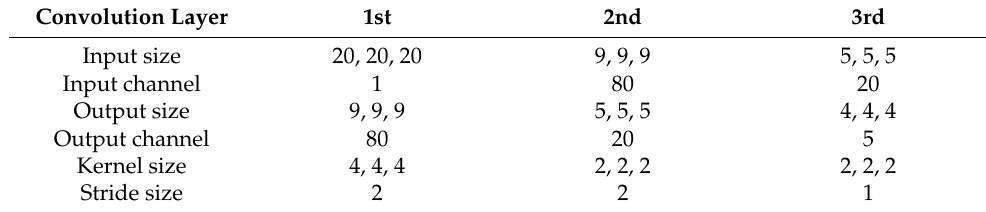
Figure 2. 3D CNN Path Loss Model Structure. Table 2. 3D CNN Path Loss Model